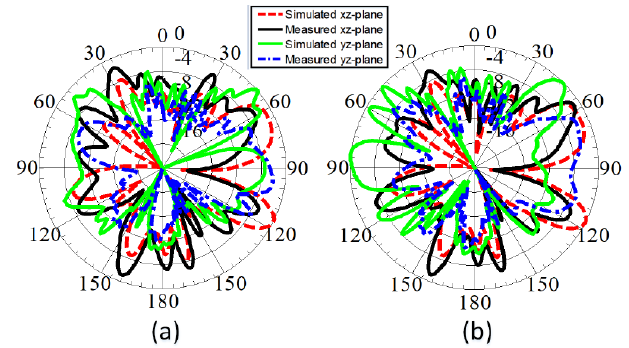
Figure 13. Measured and simulated gain patterns: ( a ) Ant − 1 at 28 GHz, ( b ) Ant − 2 at 28 GHz.